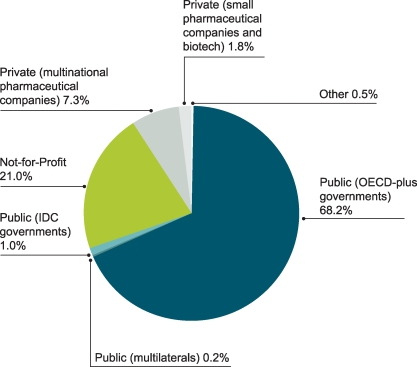
Total R&D Funding by Funder Type in 2007